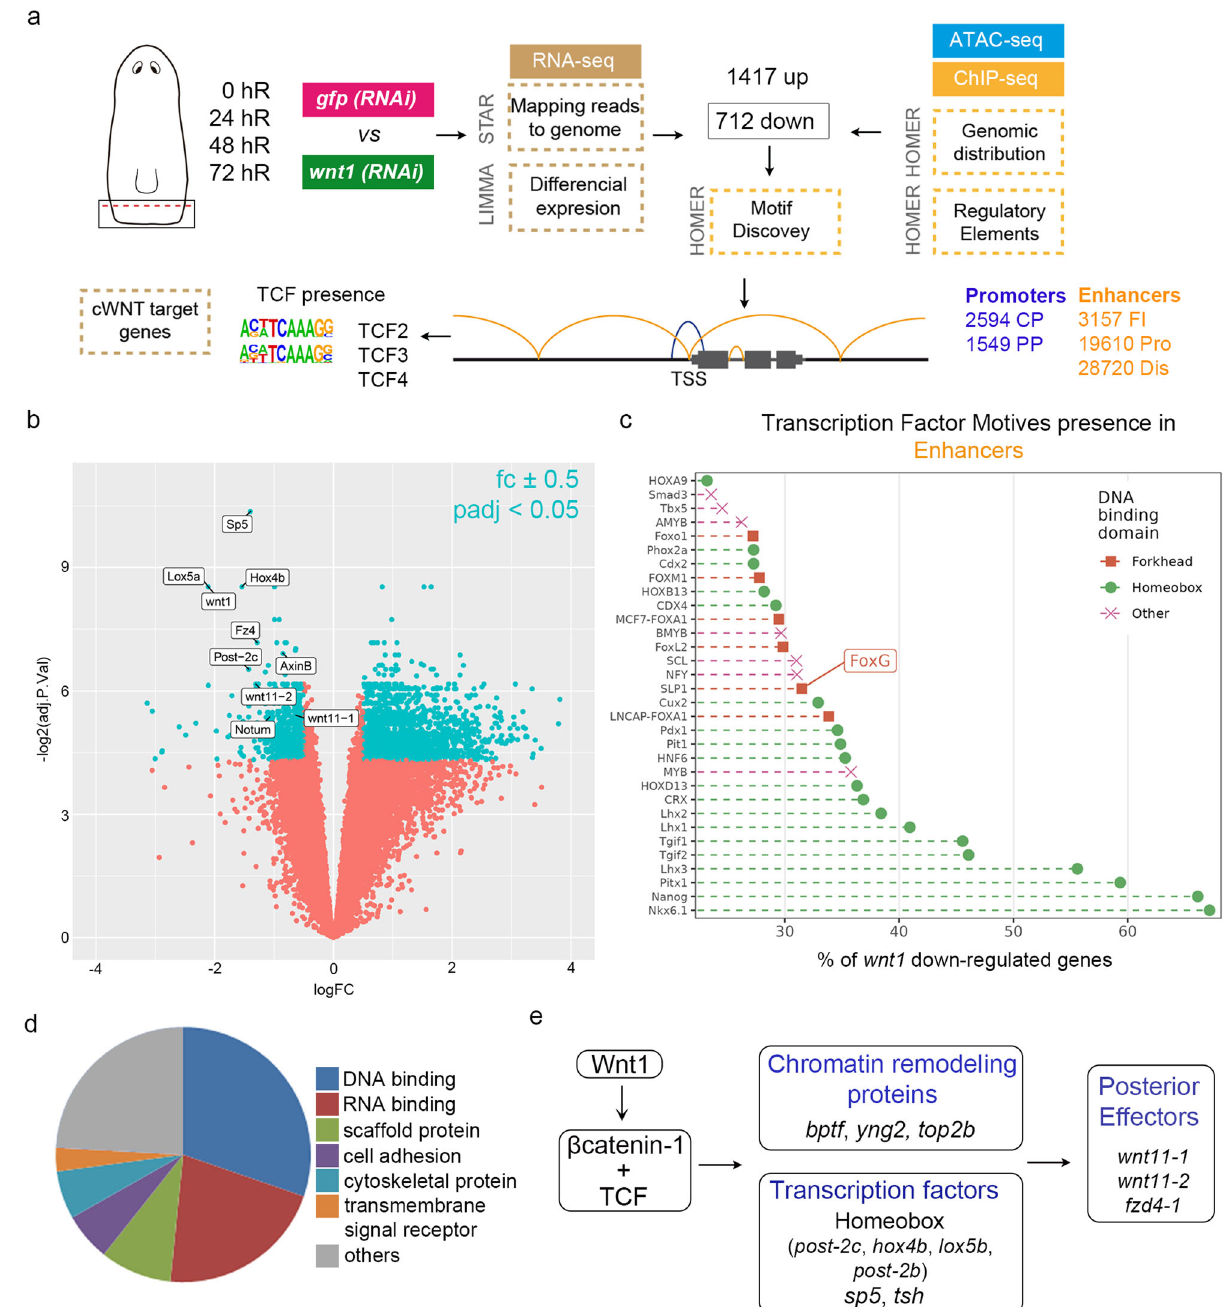
Fig. 2 | Homeobox TFs motifs are found enriched in cis-regulatory elements of wnt1 (RNAi)downregulatedgenes.a Work fl owtoidentifydifferentiallyexpressed genes, cis -regulatoryelements(CRE)andtranscriptionfactors(TFs)associatedwith wnt1 (RNAi).Nexttoeachwork fl owthe programused isindicated.Motif discovery for TCF binding sites was speci fi cally performed in downregulated wnt1 (RNAi) genes. b Volcano plot of 72 hR shows the (694) down- and (1409) upregulated genes after wnt1 inhibition, which present fold change (fc) ± 0.5 and p -value adjusted (padj) <0.05 (FDR on lima-voom empirical Bayes moderated t-test).